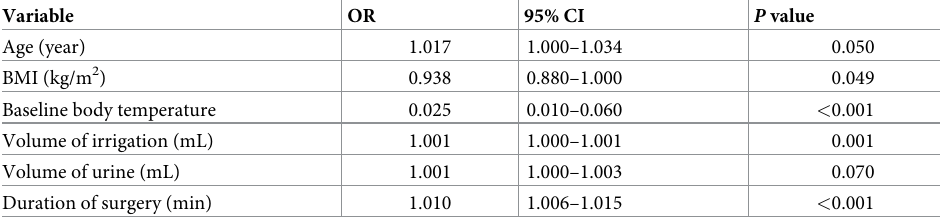
Table 2. Risk factors for inadvertent hypothermia on multivariate logistic regression analysis.